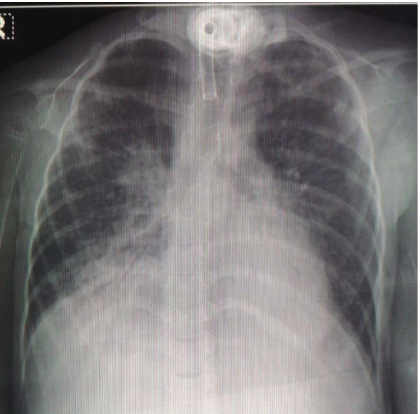
Figure 1: Chest X-ray prior to COVID-19: clear lung fields bi- laterally with minimal veiling of the right middle lobe, tracheos- tomy in situ.